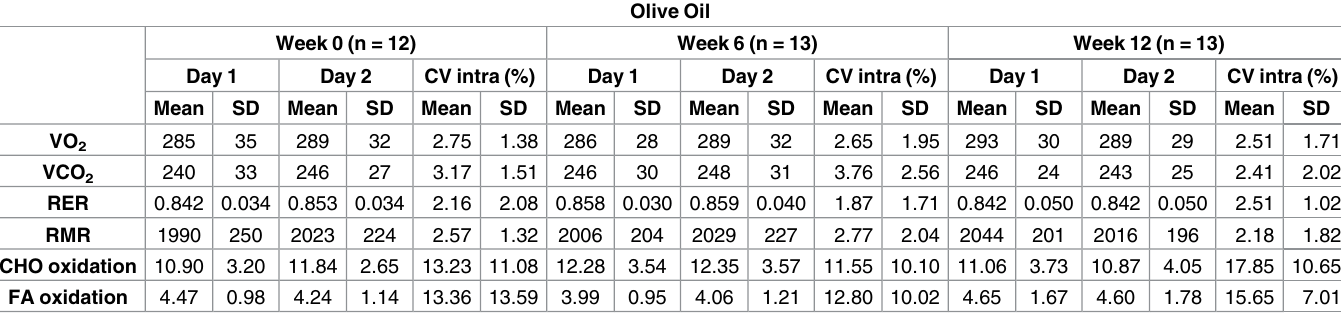
Table 2. Resting metabolic rate, substrate oxidation, and within individual coefficient of variancebetween consecutive day measurements with olive oil supplementation.